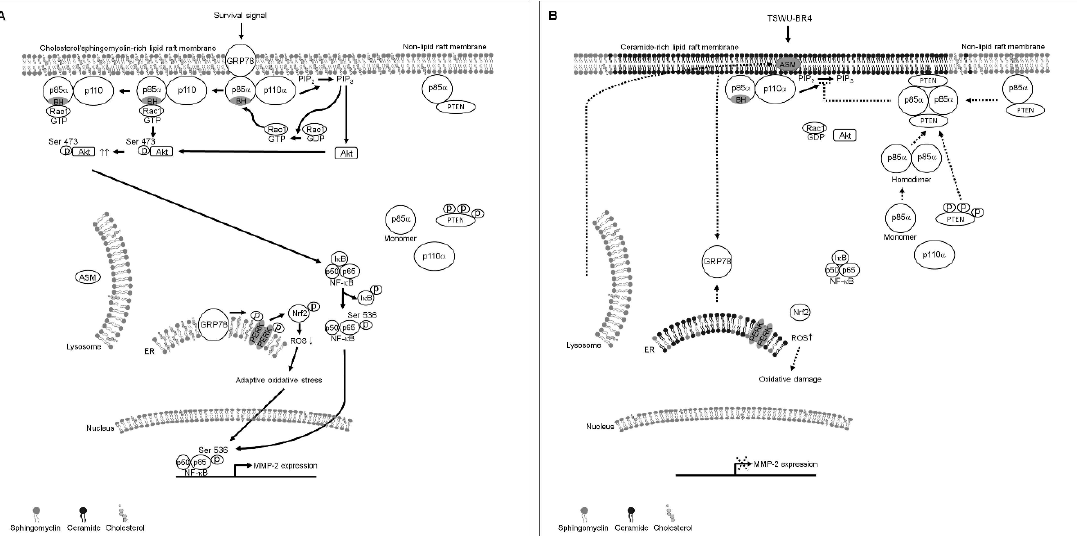
Figure 7. A molecular model for the induction of the inhibition of cancer cell invasion by TSWU-BR4. ( A ) The selective interaction of clustered GRP78 − PI3K − Akt − GTP-Rac1 signaling molecules in the lipid raft membranes constitutes a central element in the initiation of ER lipid raft membrane-associated GRP78 − PERK − Nrf2-mediated oxidative stress balance and NF- κ B − MMP-2-mediated cell invasion in response to survival signals. ( B ) Under the condition of cellular TSWU-BR4 uptake, TSWU-BR4 triggers the lipid raft membrane translocalization of ASM from lysosome to promote the generation of ceramide-rich lipid raft membranes, thus inducting the formation of p85 α –unphosphorylated PTEN tetrameric complexes and thereby disturbing the interaction between GRP78 and p85 α in the lipid raft membranes. The lipid raft membrane targeting of ASM also lead to the translocation of GRP78 from the ER into the cytosol by displacing cholesterol with ceramide in the ER lipid raft membranes, causing oxidative damage-induced inhibition of cell invasion. The resulting lipid raft membrane-associated p85 α –PTEN complexes can negatively regulate Akt activity and attenuate Rac1 activation by dephosphorylating the 3-position of PIP 3 to PIP 2 . Akt inactivation was accompanied by attenuation of NF- κ B-mediated MMP-2 expression, which can result in the suppression of the invasive activity of cancer cells.